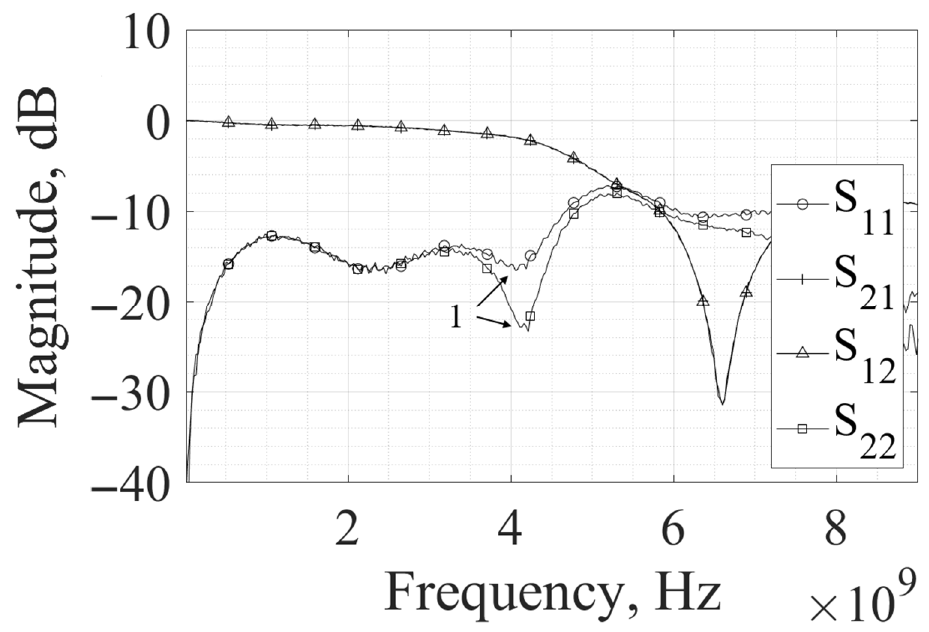
Figure 5. S parameters of the sample of the studied system installed randomly on the MSL: 1—the asymmetry occurrence of the reflection coefficients.